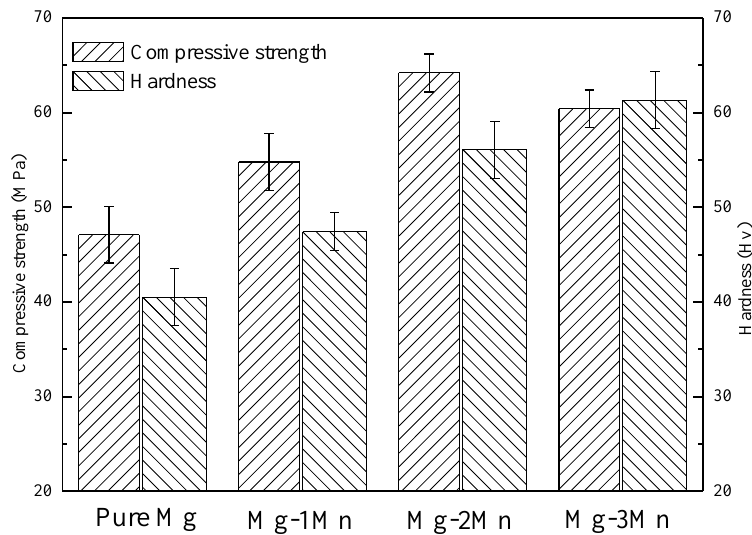
Figure 4. The compressive strength and hardness of Mg-Mn alloys.